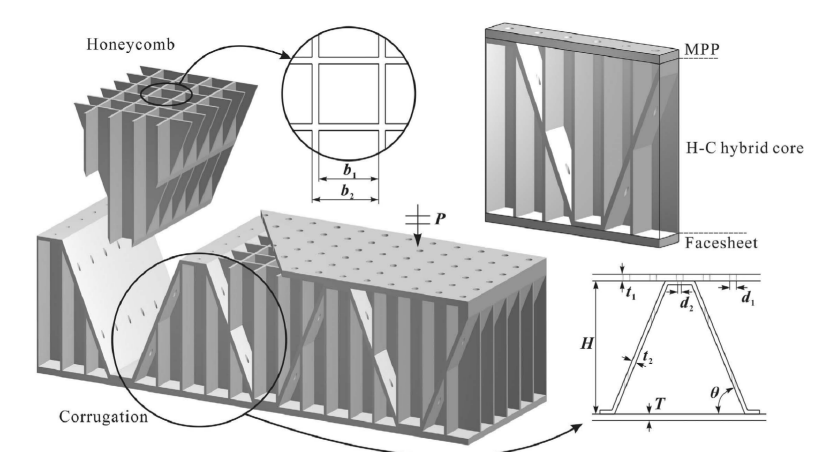
Figure 5. Image from [48]. An absorbing metamaterial composed of various different Helmholtz resonators separated by microporous septa. The reference values for parameters are d 1 , t 2 , d 2 , T = 1 mm, t 1 = 2 mm, b 1 = 3.6 mm, b 2 = 4 mm, H = 20 mm, and these can be tuned to obtain the maximum absorption at the desired frequency (e.g., an absorption peak at 580 Hz is obtained with H = 60 mm d 2 = 0.2 mm and d 1 = 1.3